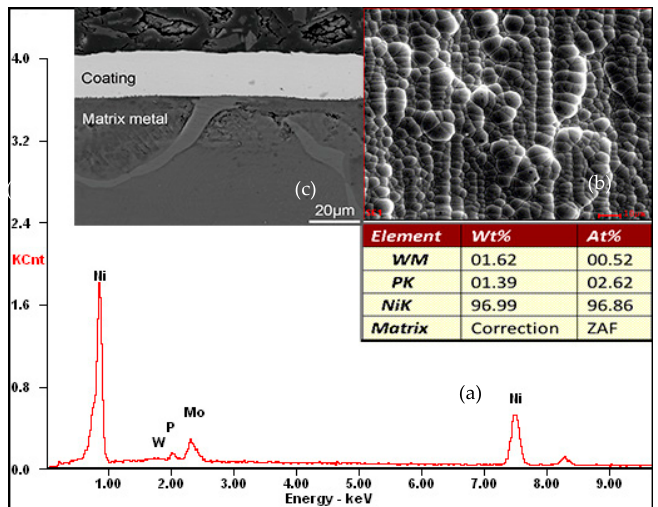
Figure 10. Chemical composition and morphology of the Ni–W–P coating on AZ91D cast magnesium alloy. ( a ) Chemical composition by EDS; ( b ) Cross-section morphology; ( c ) Surface morphology.